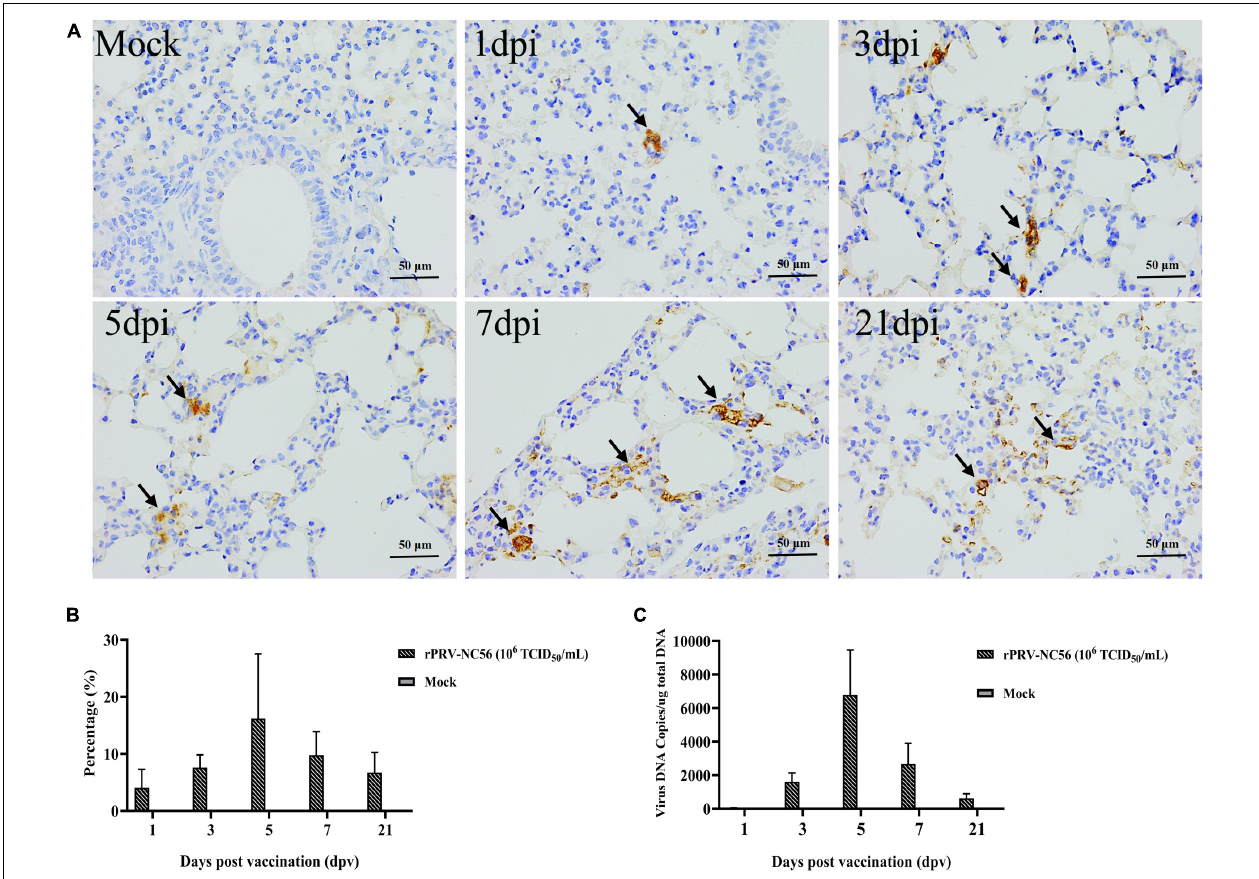
FIGURE 6 | The colonization properties of rPRV-NC56 in mouse lungs. (A) IHC identification of GP5 protein expression in the mouse lungs of rPRV-NC56-infected mice at 1, 3, 5, 7, and 21 dpv. The brown precipitate indicated by the black arrow indicates the cells expressing GP5 protein ( × 400). (B) Percentage of positive cells expressing GP5 protein identified by IHC. (C) qPCR identification of gB gene in the lungs of rPRV-NC56-immunized